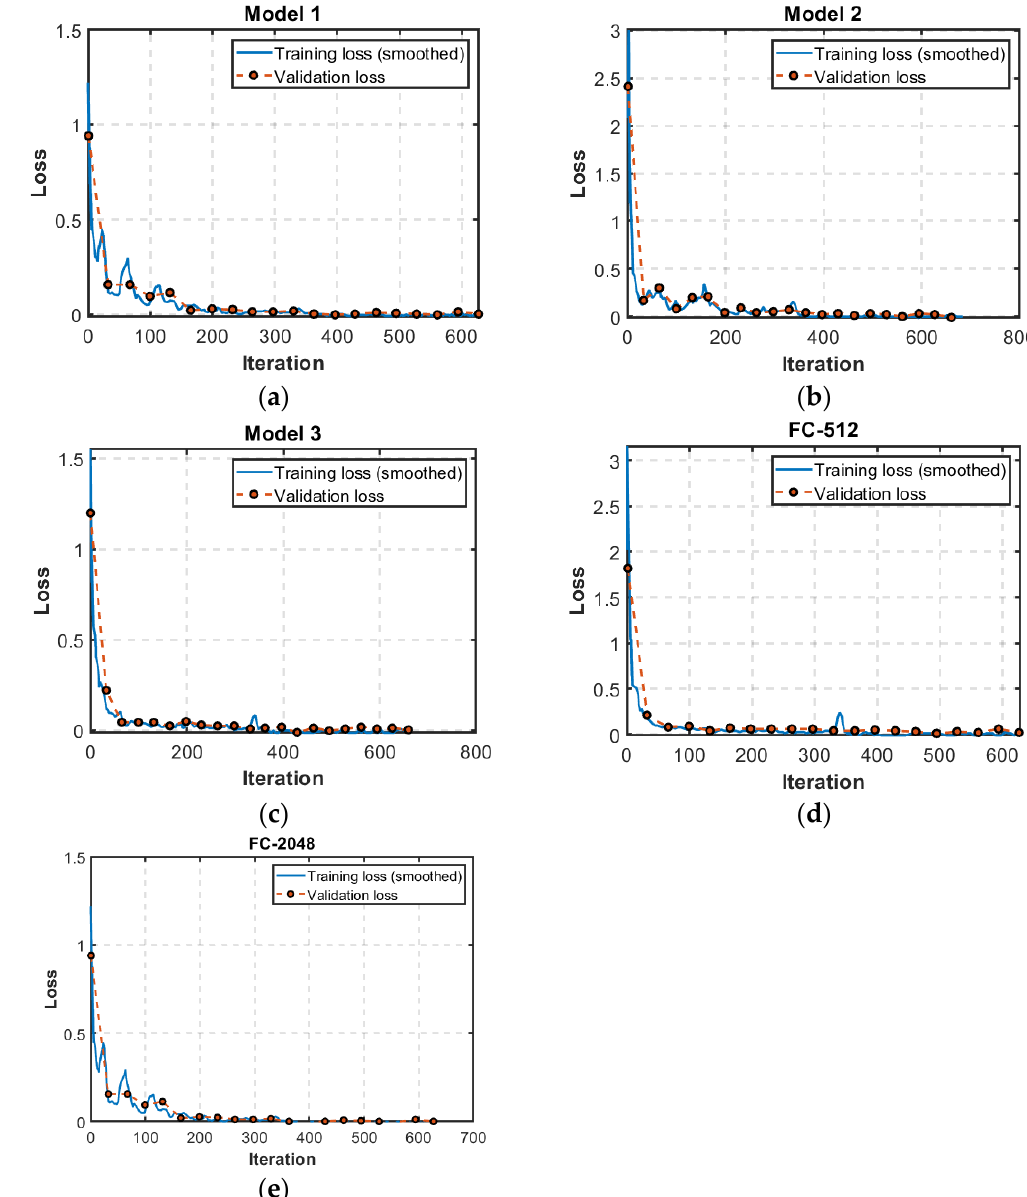
Figure 4. Loss function minimization process of five different CNN configurations: ( a ) Model 1; ( b ) Model 2; ( c ) Model 3; ( d ) FC-512; ( e ) FC-2048. The experiment is based on the simulated sea surface scattering dataset at 13.9 GHz, 5.5